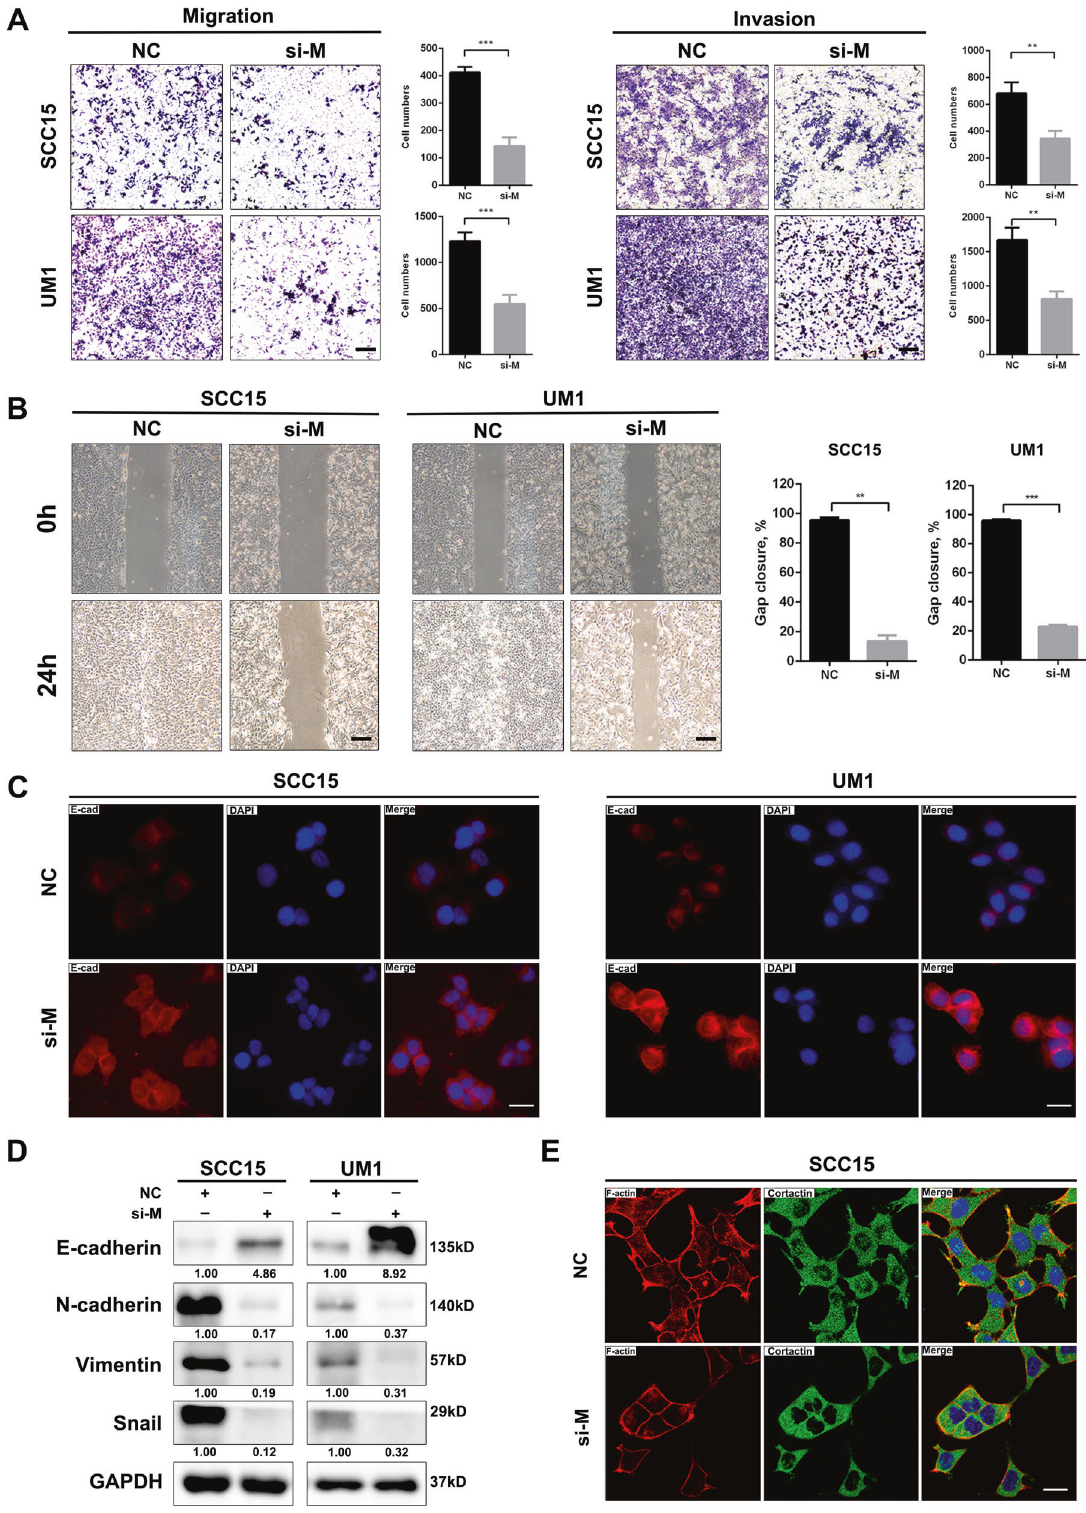
Fig. 3 MALAT1 silencing weakens the motility capacity of HNSCC cells in vitro. A Transwell assay showed that MALAT1 knockdown hindered the migration and invasion of SCC15 and UM1 cells. Scale bar, 100 μ m. B Representative images of gaps in HNSCC cells transfected with si-MALAT1 and negative control at the beginning (0 h) and the endpoint (24 h) of wound healing assay were shown. MALAT1 depletion retarded the wound-healing process in HNSCC cells. Scale bar, 200 μ m. C The immuno fl uorescence staining of E-cadherin in SCC15 and UM1 cells transfected with MALAT1 siRNAs and negative control, respectively. Scale bar, 20 μ m. D The proteins of E-cadherin, N-cadherin, Vimentin and Snail were determined by western blot assay in si-MALAT1-transfected HNSCC cells. E Representative images of immuno fl uorescence of F-actin and Cortactin in SCC15 cells transfected with si-NC or si-MALAT1 were shown. Scale bar, 20 μ m. Data in this fi gure, mean ± SD, ** P < 0.01, *** P < 0.001. NC negative control. si-M si-MALAT1. Cell Death and Disease (2023)